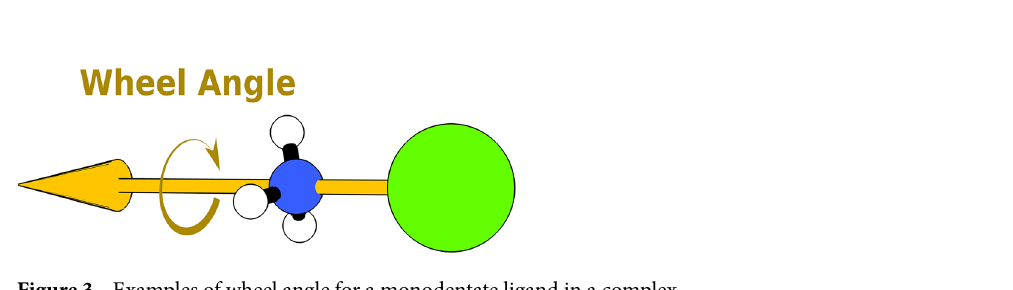
Figure 2. Euler angles centered at the ligand, here shown to be a 2,2-bipyridine. Nitrogens are colored purple so as not to be confused with the blue Z axis.